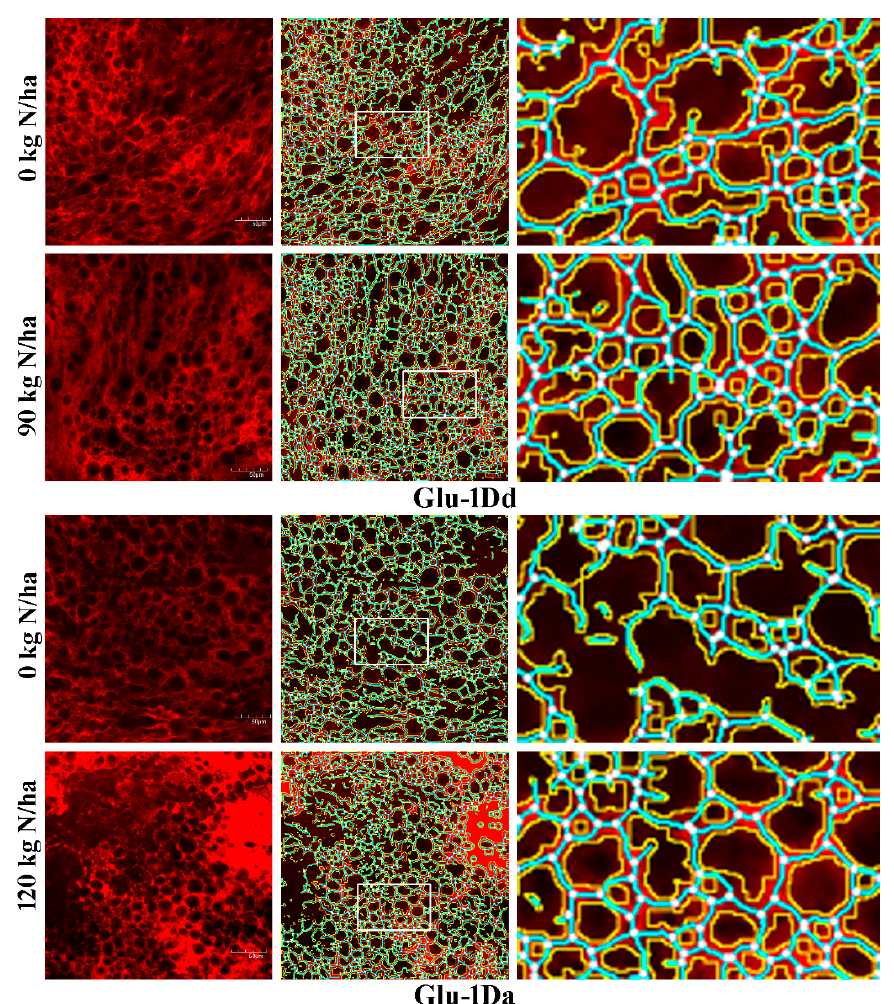
Figure 7. Protein network analysis for dough produced with Glu-1Dd and Glu-1Da under N application. The images in the left column are the original CLSM images, and the scale bar represents 50 µm. The images in the middle column were processed with AngioTool. The images in the right column show the enlarged areas selected from the processed images highlighted by the white boxes, where the junctions are shown in white, the protein skeleton in blue, and the protein outline/area in yellow.